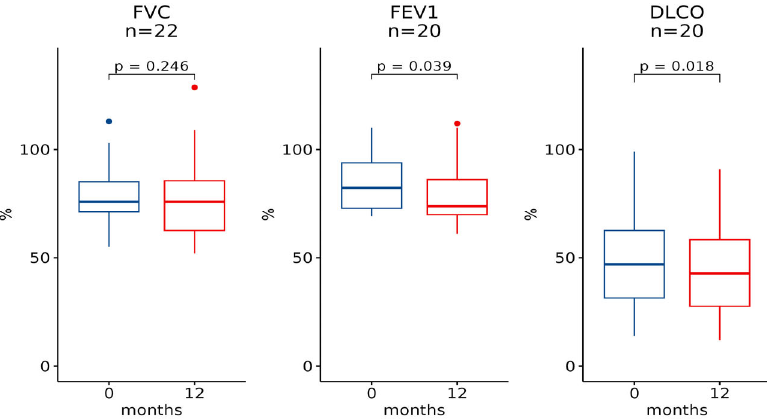
Figure 2. The 12-month trend for spirometry measurements. Box-plots representing levels of FVC, Figure 2. The 12 ‐ month trend for spirometry measurements. Box ‐ plots representing levels of FVC, FEV1 and DLCO at baseline and after 12 FEV1 and DLCO at baseline and after 12 months.